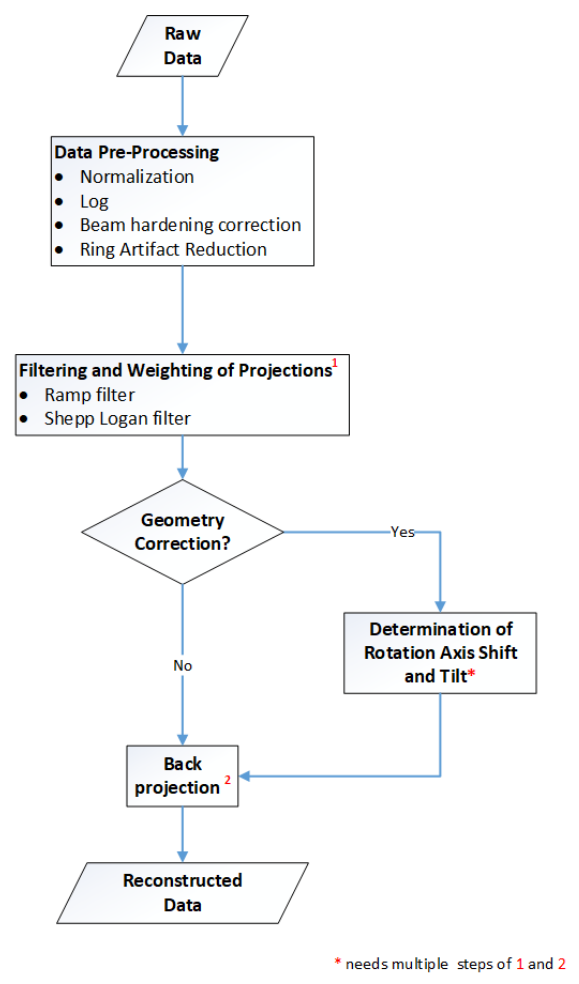
Figure 1. Overview: Workflow of CT